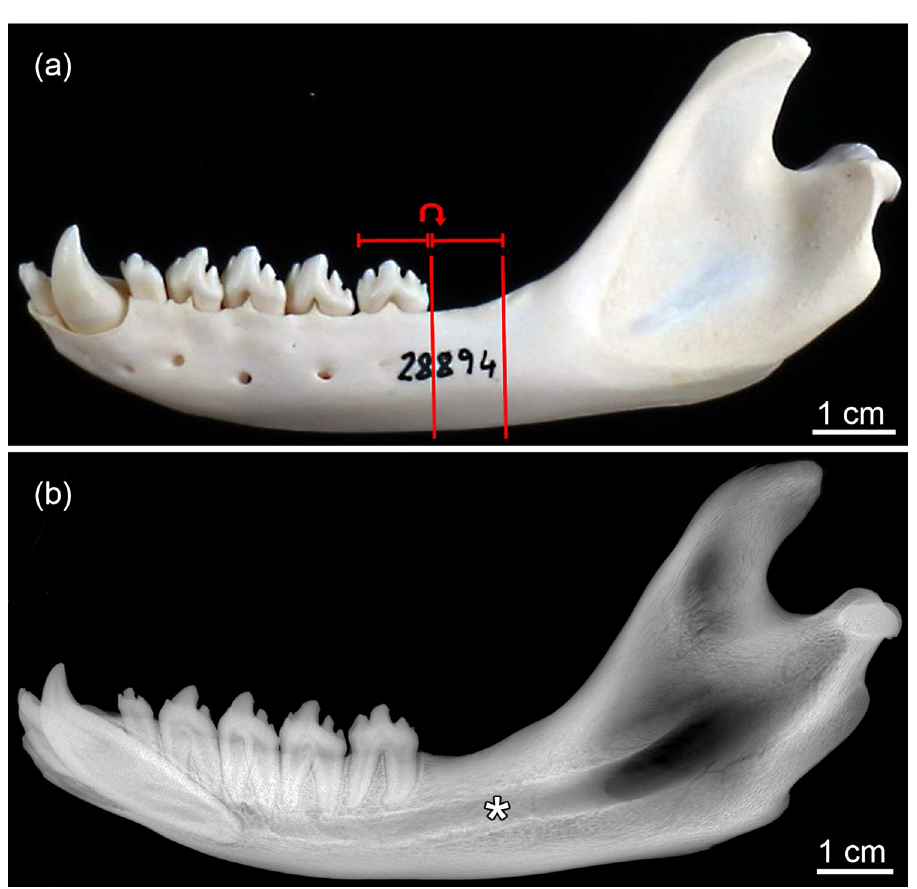
Fig 1. Mandibles of harbor seals ( Phoca vitulina ). (a) Lateral view of the left mandible of a 10-month-old individual. The measurement area in the retromolar region is indicated by the vertical bars. The width of the measured area equals the mesiodistal length of the tooth crown of the M 1 , the posteriormost of the five postcanine teeth. (b) X-ray image (lateromedial projection) of the left mandible of a 20-month-old individual, showing the distribution of compact and cancellous bone and the size of the mandibular canal